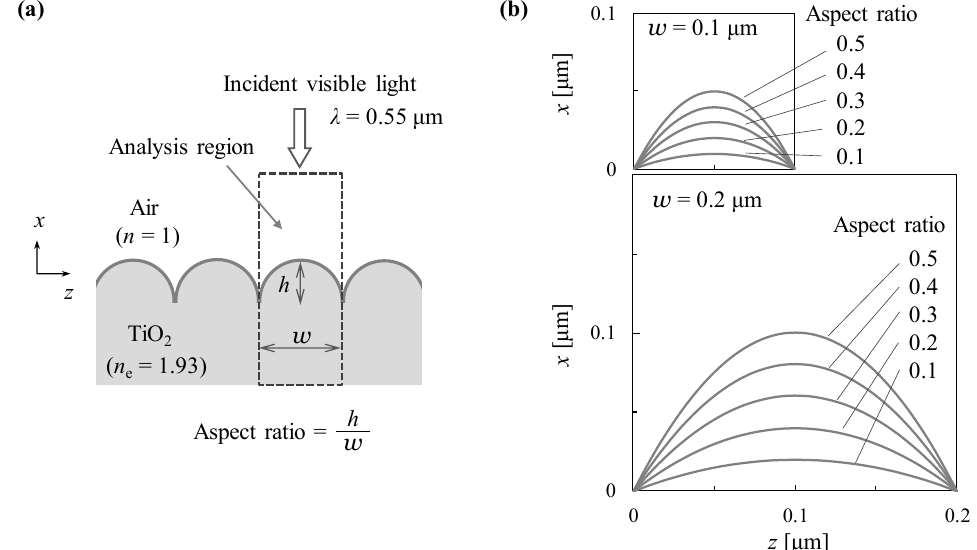
Figure 2. Numerical simulation model: ( a ) Analysis region. ( b ) Model geometries with various aspect ratios.